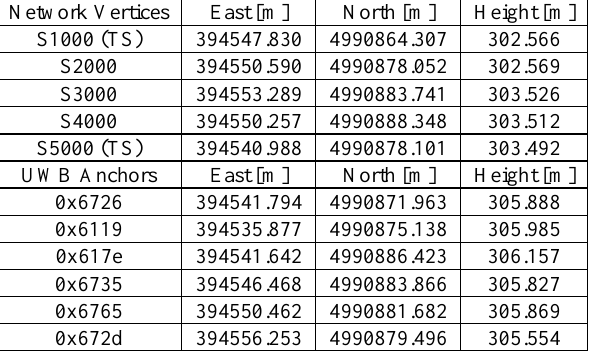
Figure 3. Graphical representation of the test with the pedestrian path moving from an outdoor space to an indoor environment. The topographic network, the UWB anchors location and the total stations position are also shown.